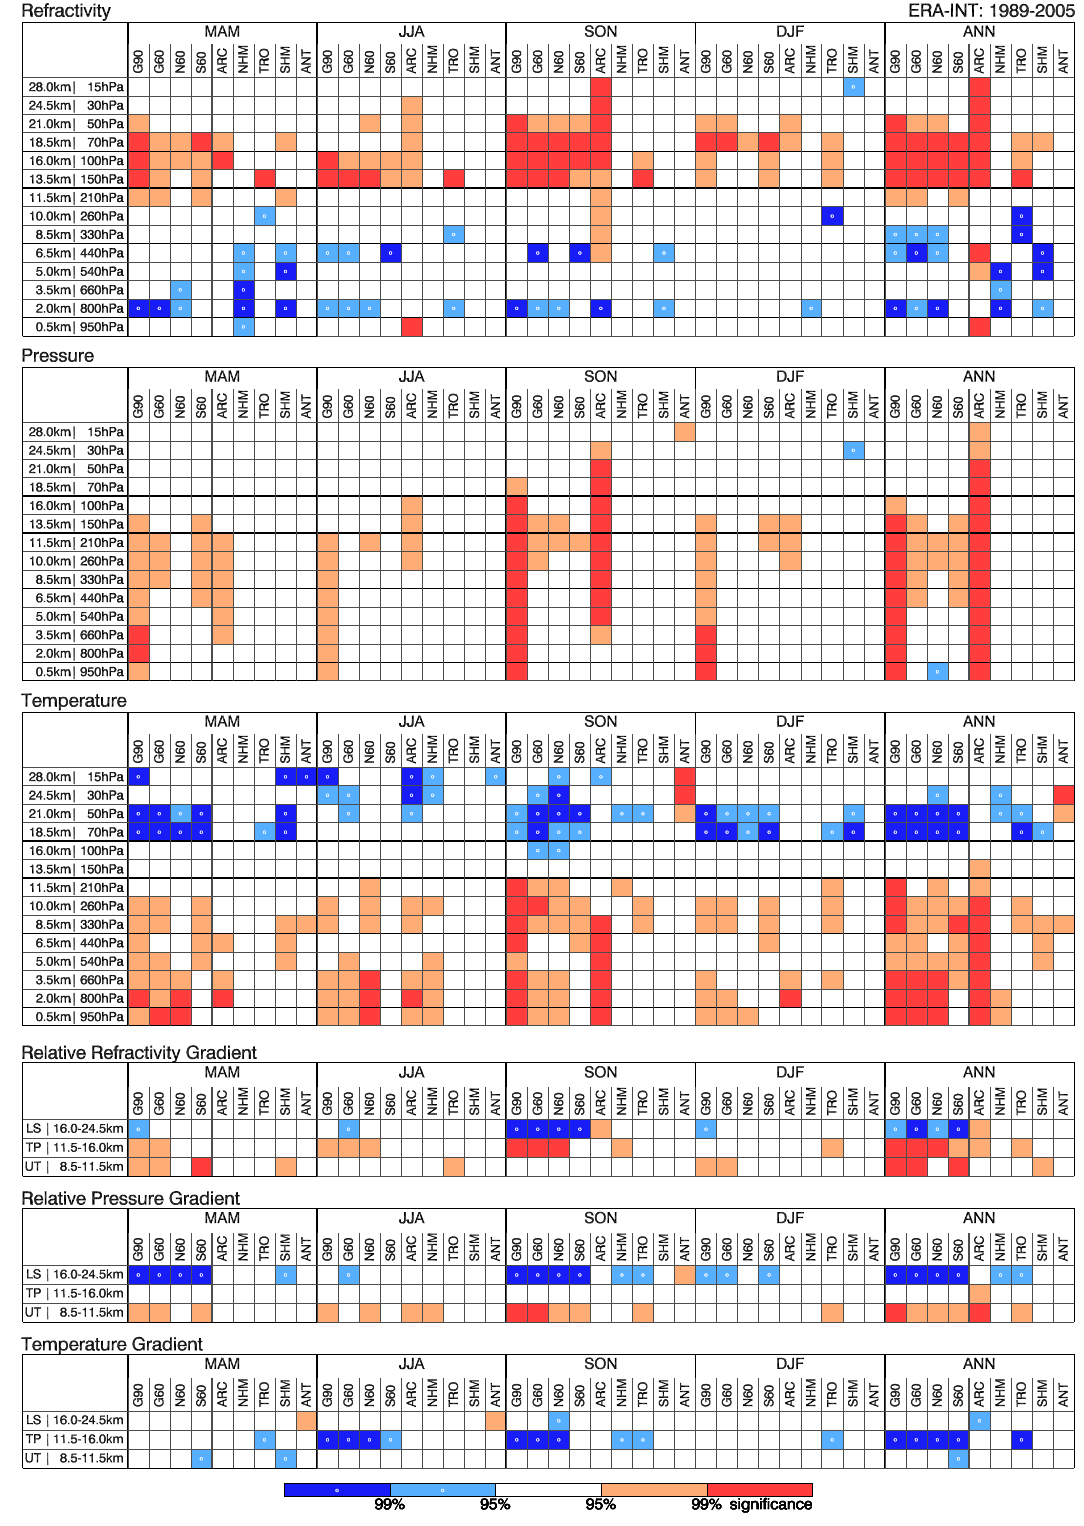
Fig. 10. Trend indicators based on ERA-INT for the period 1989 to 2005 for the RO-accessible variables refractivity, pressure, temperature, relative refractivity gradient, relative pressure gradient, and temperature gradient (from top to bottom). Same layout as Fig.